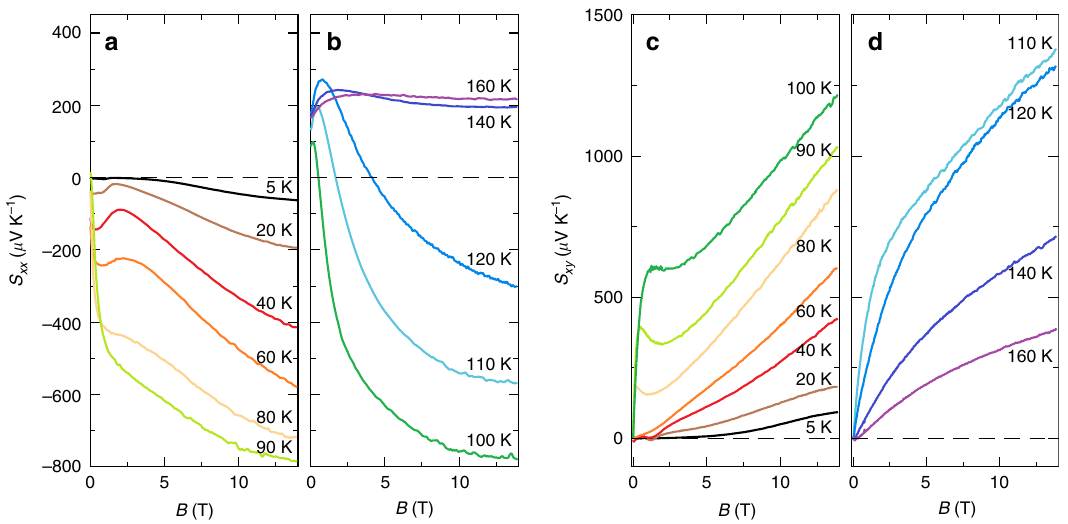
Fig. 2 Longitudinal and transverse thermoelectric coef fi cients as a function of the magnetic fi eld at different temperatures. a S xx at T ≤ 90 K, where the sign of S xx is negative at B = 0, and b S xx at T > 90 K, where the sign is positive at B = 0. c , d show S xy at T ≤ 90 K and T > 90 K, respectively.